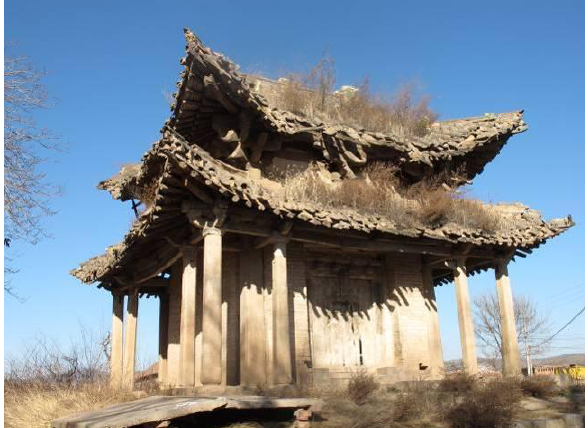
Figure 2 Sirun Sanjiao Tang date to Jin Dynasty (1115-1234 A.D.) in Lingchuan County, Shanxi Province. Not being renovated form the end of Qing Dynasty(1911 A.D.)